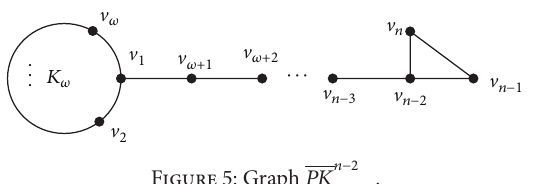
Figure 5: Graph 𝑃𝐾